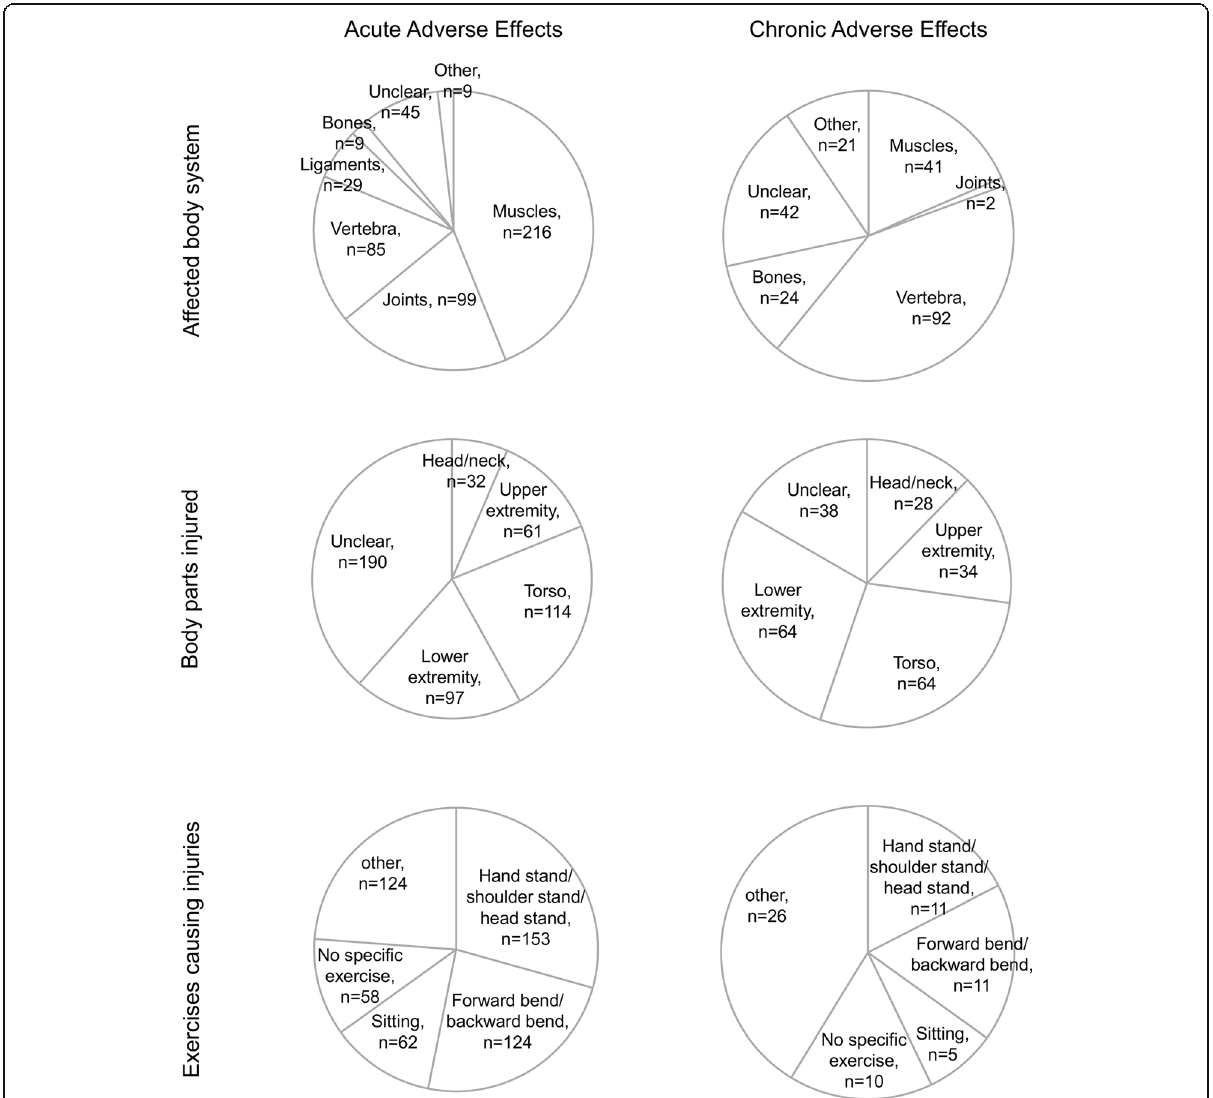
Fig. 1 Classification of acute and chronic adverse effects regarding the affected body system, the injured body parts, and the exercises associated with the